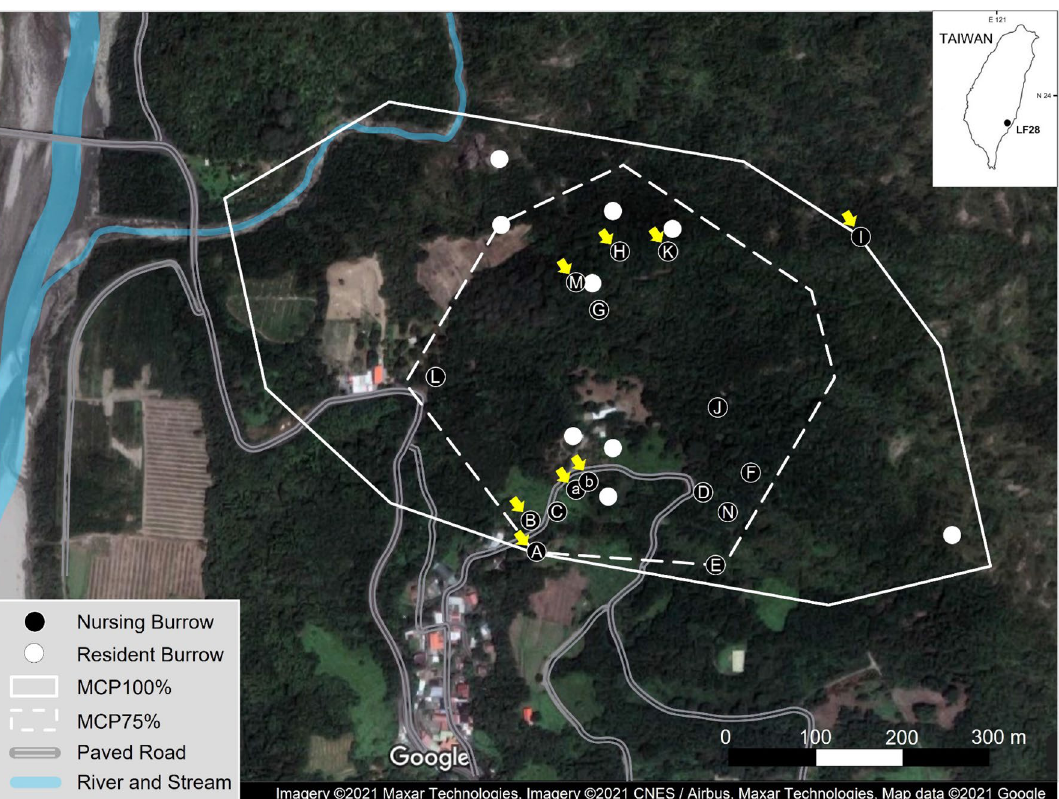
Figure 4. Study area showing the landscape, burrow sites and home range (minimum convex polygon, MCP), of a female Chinese pangolin ( Manis pentadactyla ) LF28 monitored from 2012 to 2016. The nursing burrows (black circle dot) were listed alphabetically in order of usage during the entire nursing period for her first offspring. The arrows by the natal burrows indicated the burrows where the male pangolins